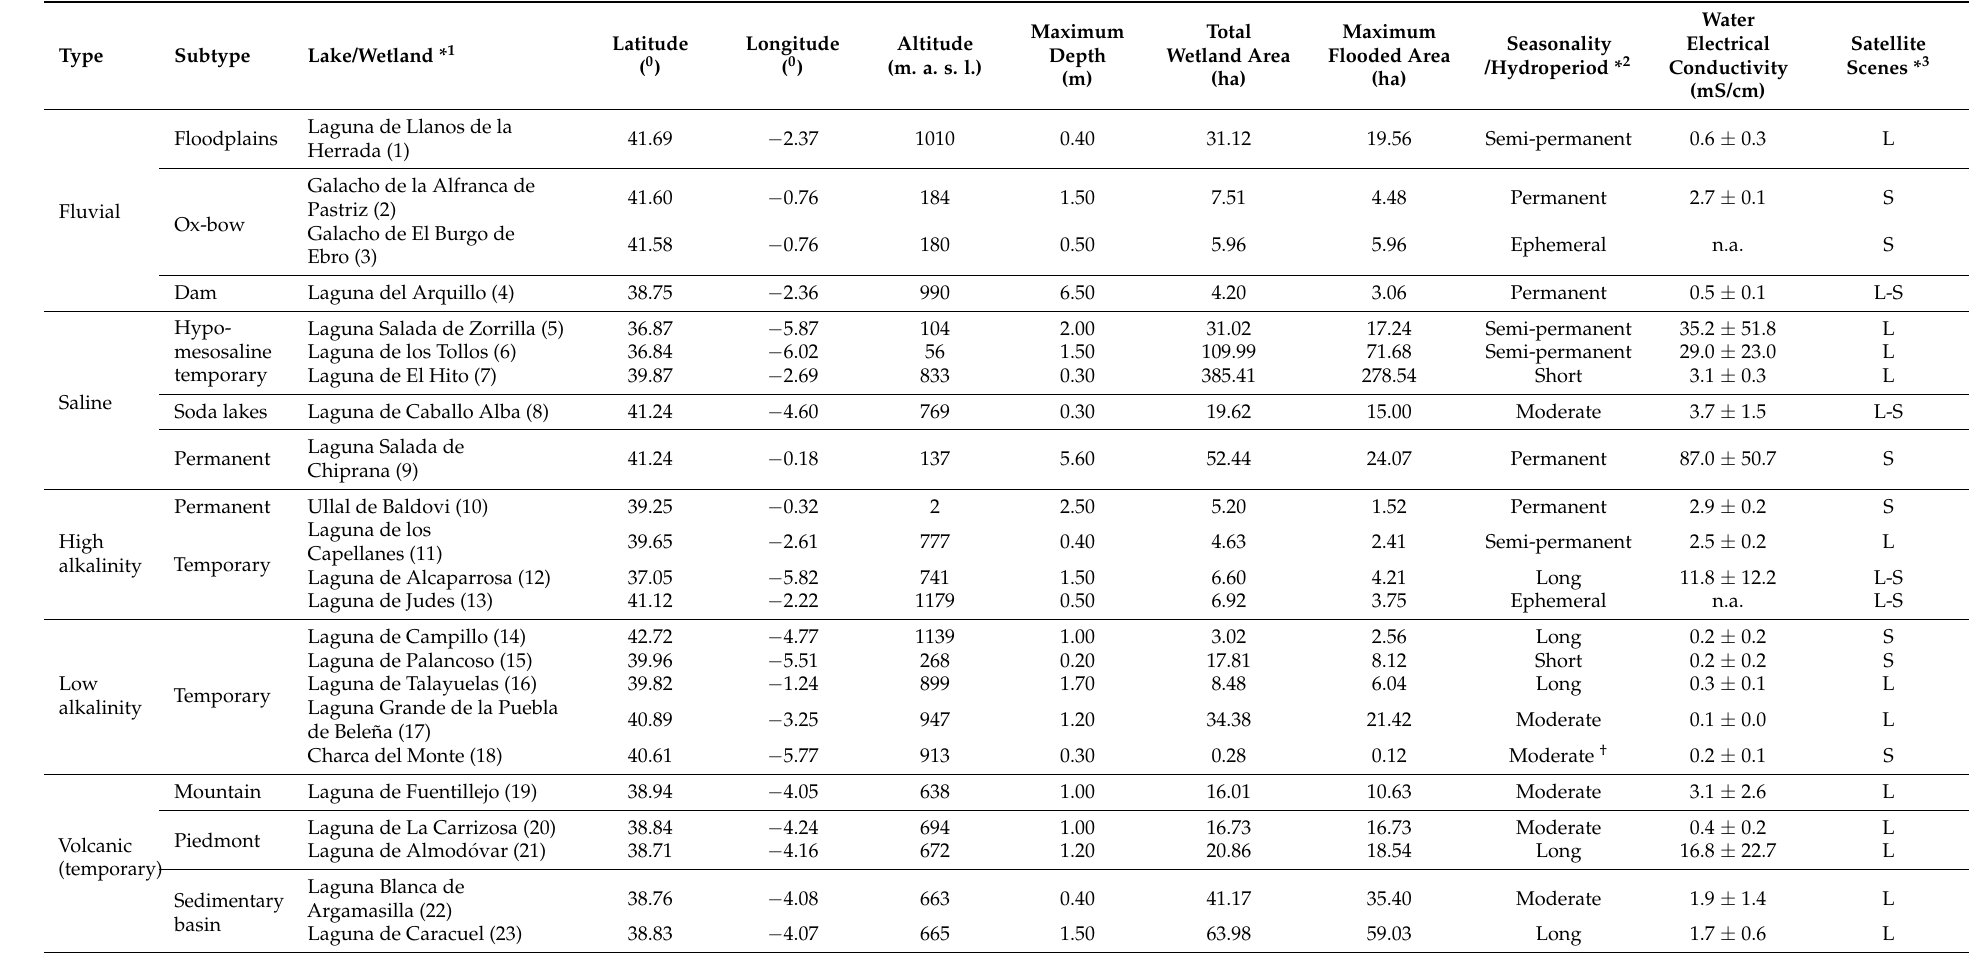
Table 2. Main features of the study water